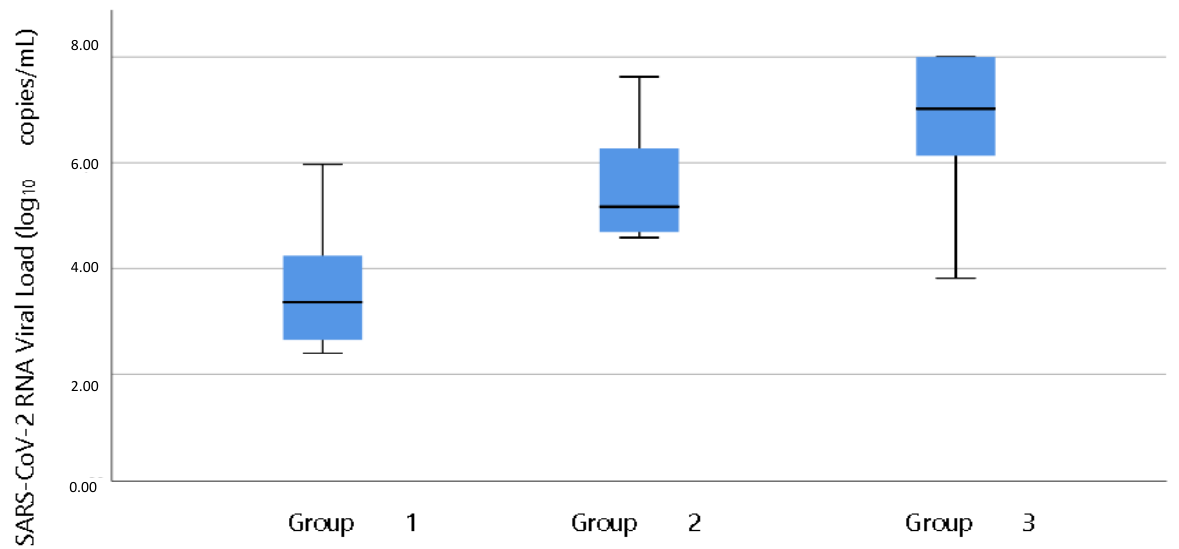
Figure 2. BOX Plot comparing cut-off index (COI) groups with viral loads. Horizontal lines represent mean, blue squares account for the interquartile range and vertical bars represent the lower and upper limits of values (range). Group 1, COI < 1; Group 2, 1 ≤ COI < 12 and Group 3, COI ≥